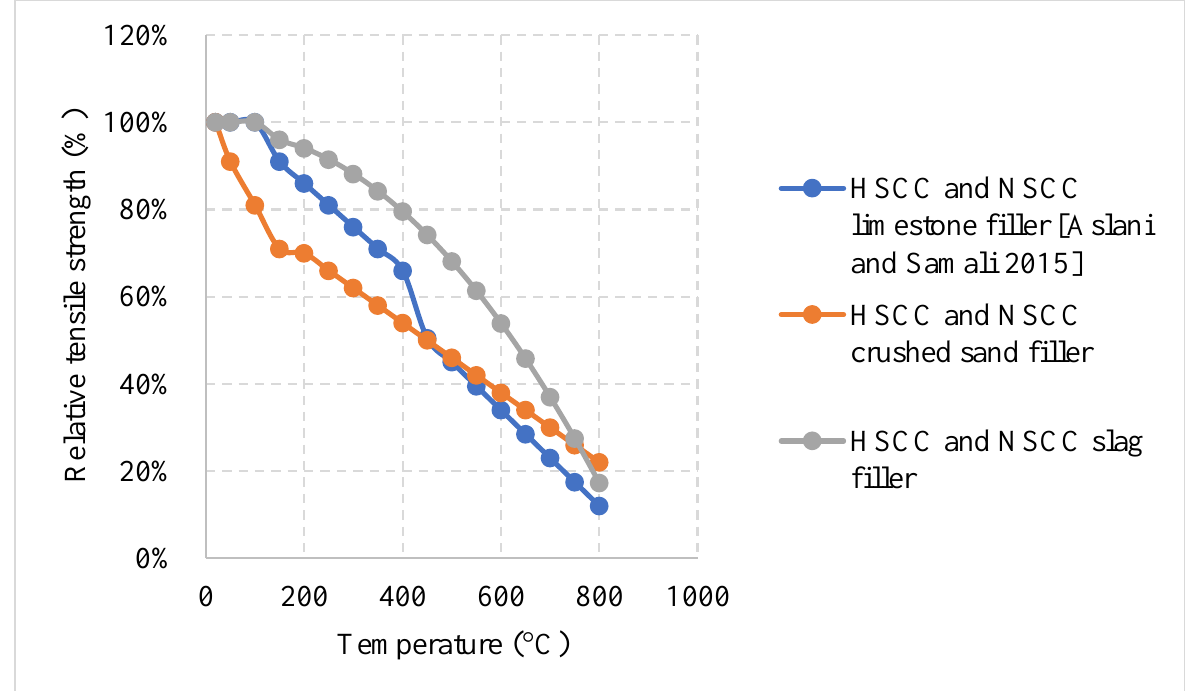
Figure 49. Relative compressive strength models for different types of concrete 2 [100].